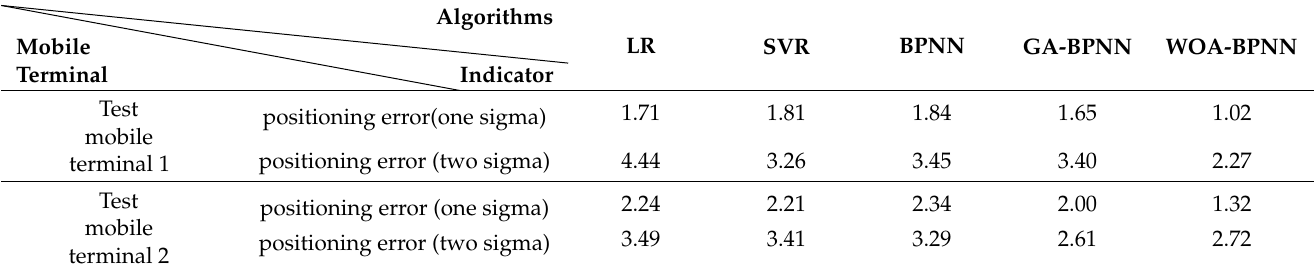
Table 1. Comparison of positioning error of five calibration algorithms (m).